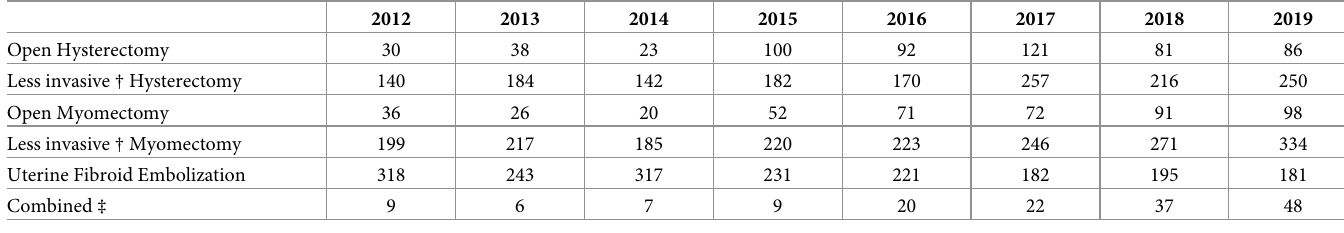
Table 1. Procedure counts in the healthcare system as a